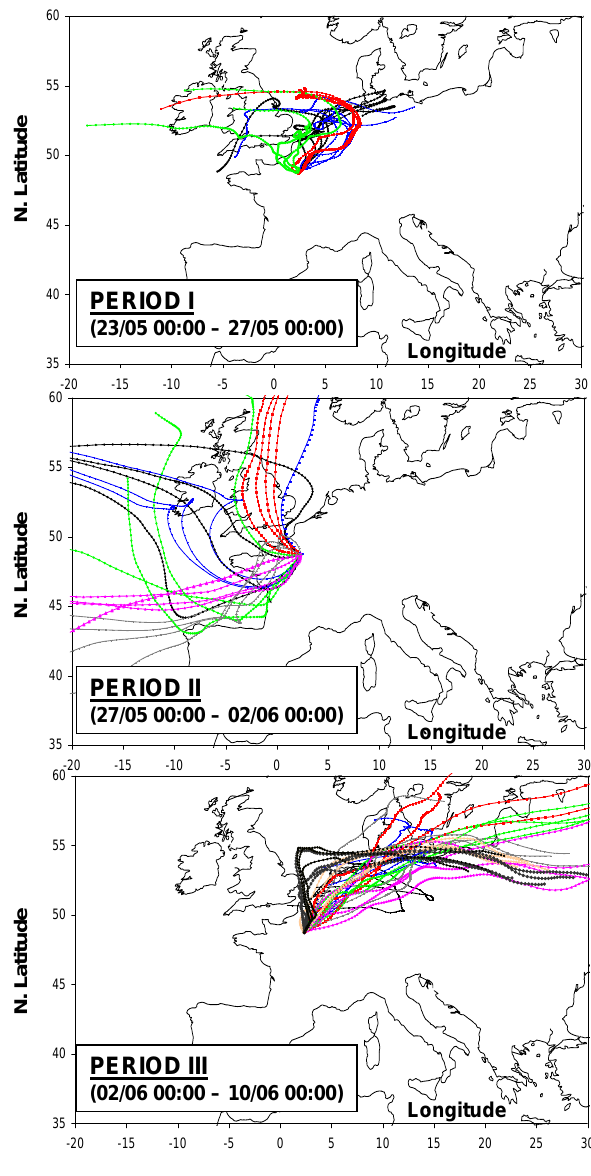
Fig. 4. 4-day backtrajectories ending at Paris (LHVP monitoring station; 500m above ground level) and calculated every 6h for the periods I (A) , period II (B) , and period III (C) depicted in Sect. 4.1. ond period (7 days: 27 November 00:00–2 June 00:00